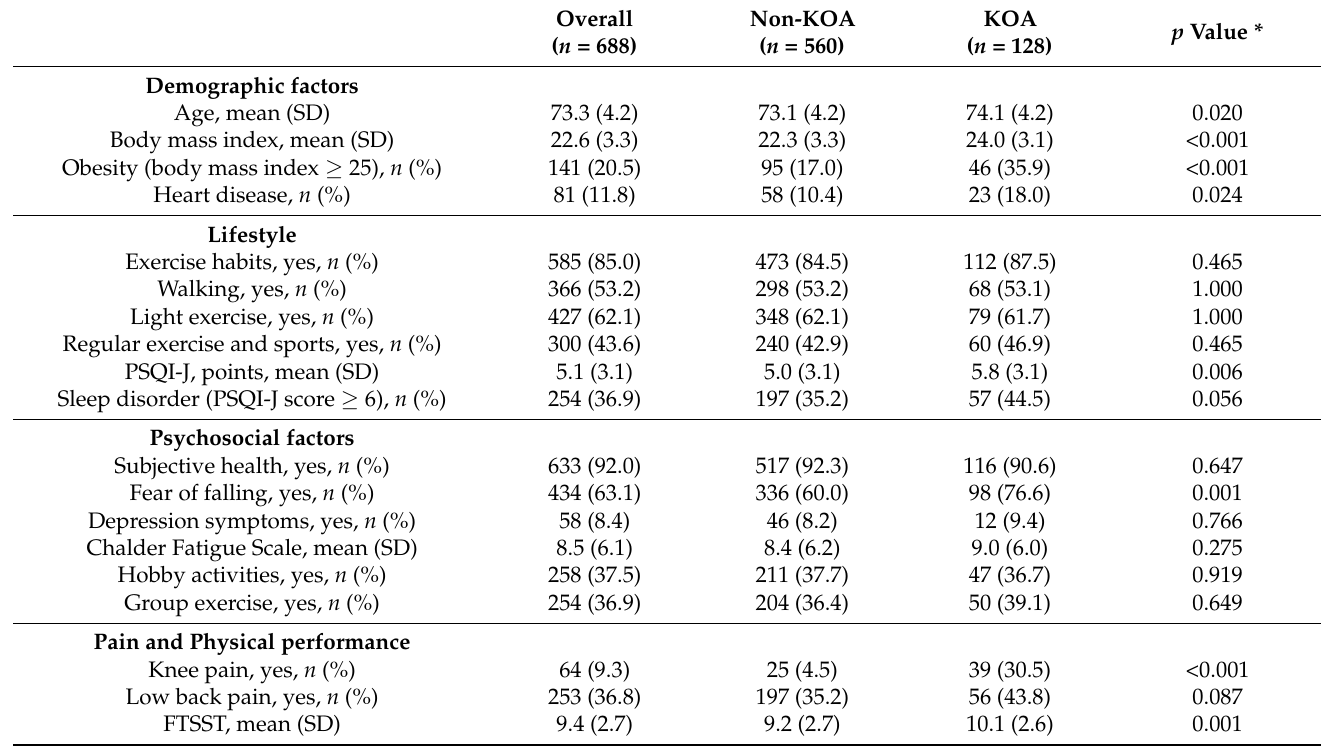
Table 1. Characteristics of the 688 older women.